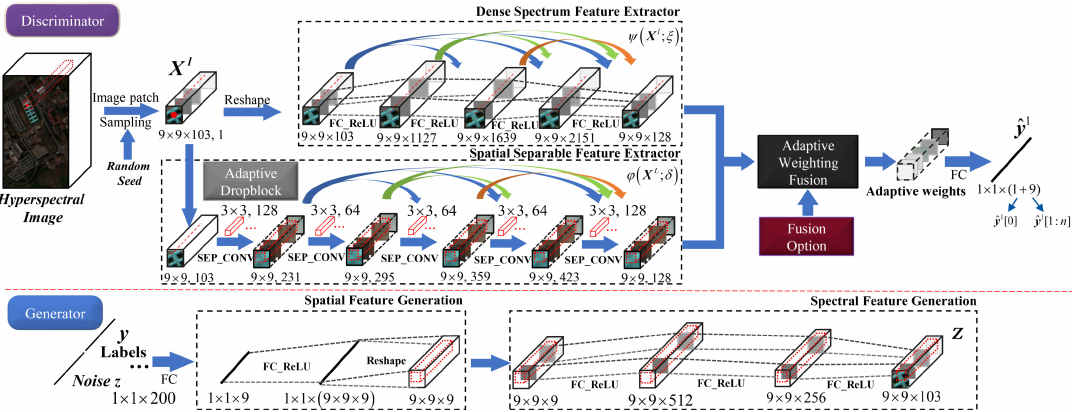
Figure 5. Adaptive weighting feature fusion discriminator ( upper ), consisting of a dense spectrum and spatially separable feature extractors. Their resulting features are fed into an adaptive weighting fusion model, which outputs a vector that indicates whether the data is fake or real and contains categorical probabilities. A generator ( lower ) contains consecutive spatial and spectral feature generation blocks to generate synthetic HSI cuboid Z